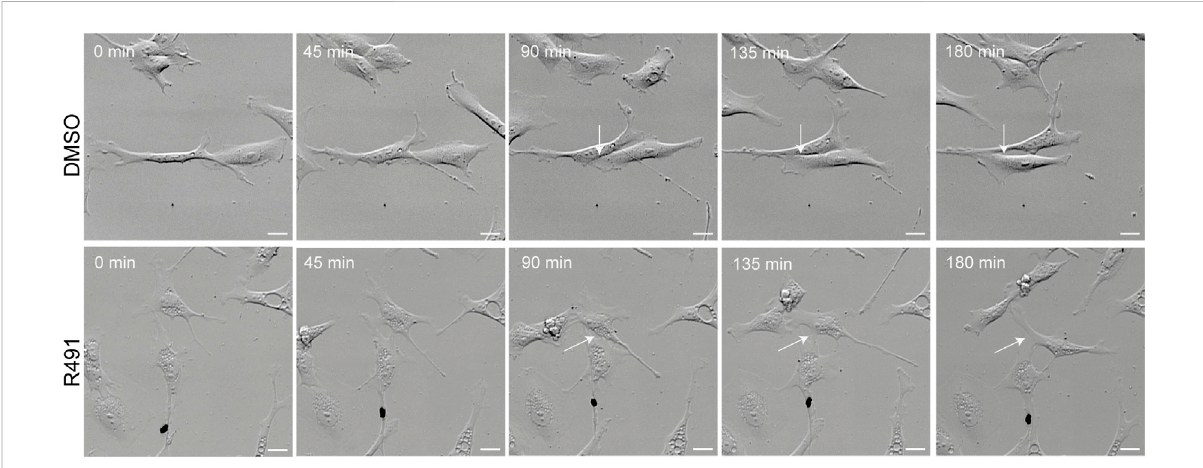
FIGURE 5 R491-treated cells migrate past other cells in a non-coordinated manner with lamellipodia-like protrusions. Montage of 5 sequential images (time frame of 45 min) of a movie showing representative control- or R491-treated BJ-Ras cells, as indicated. White arrows indicate the protrusions between cells as they migrate. Scale bars: 50 μ